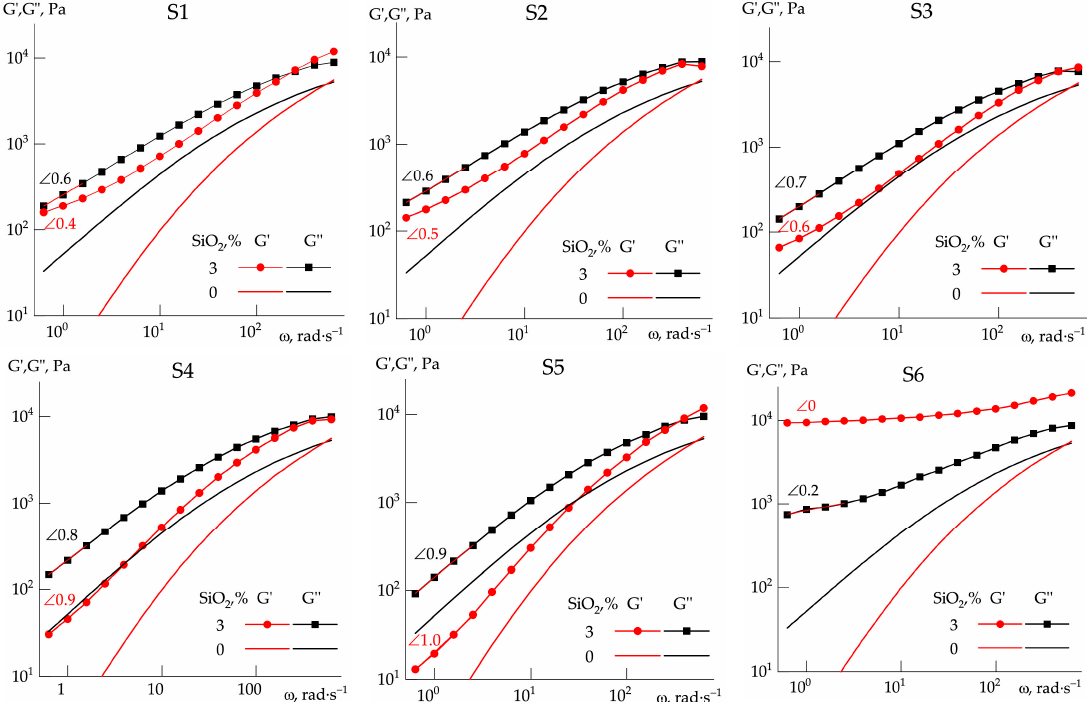
Figure 6. Frequency dependences of elastic and loss moduli for systems prepared by methods S1 − S6. The slopes for the terminal regions are shown by “ ∠ ”. Silica concentration is at the solution